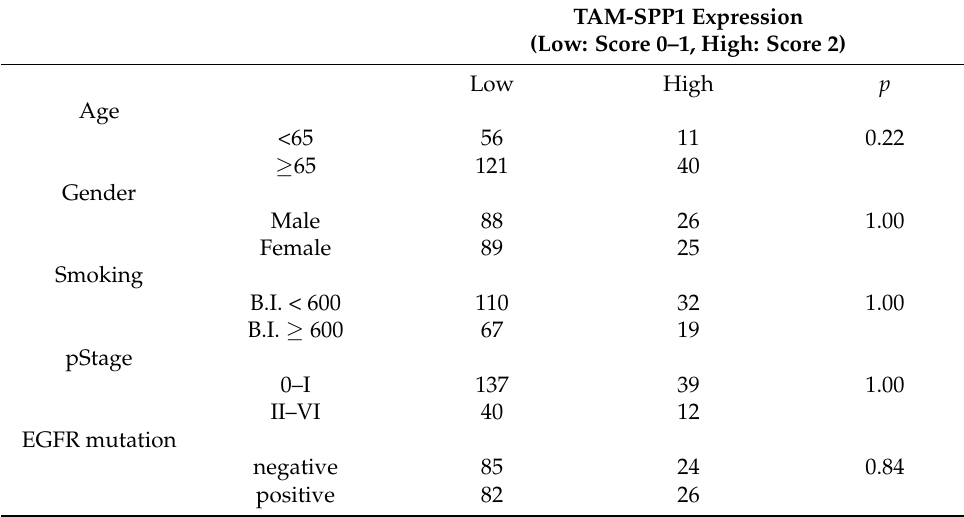
Table 2. TAM-SPP1 expression and clinicopathological factors; adenocarcinoma.